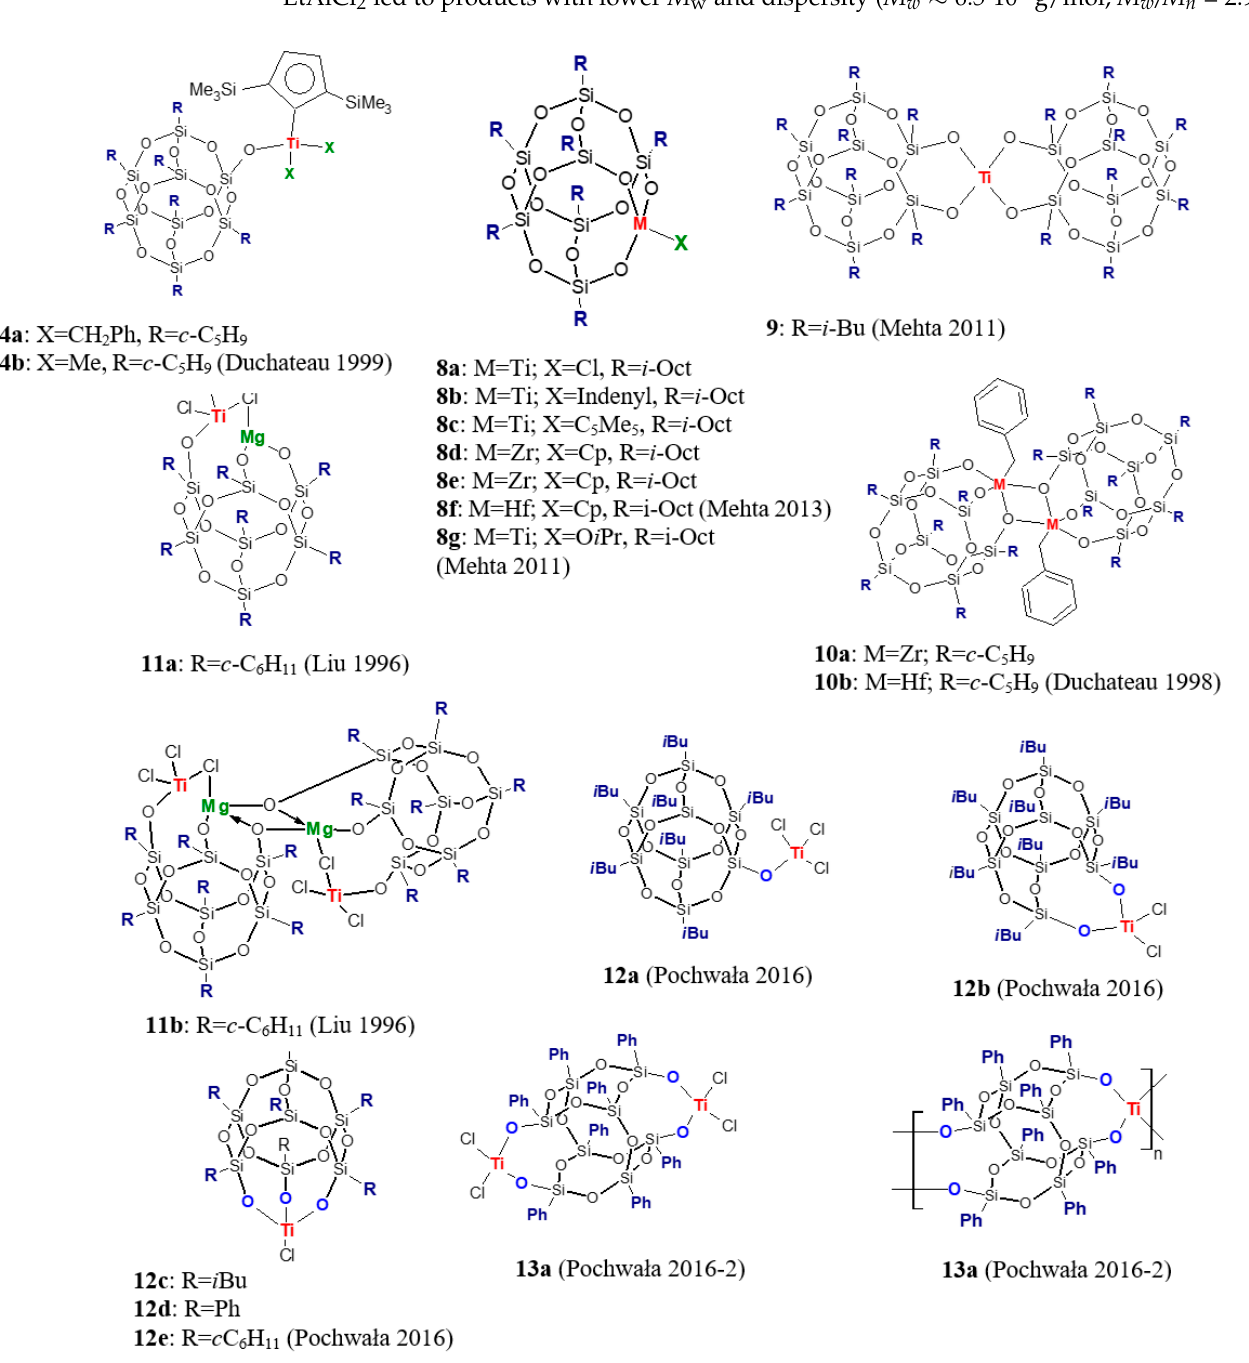
Figure 2. The fourth group transition metals complexes bearing silsesquioxane ligands used in olefin polymerization [39,43–48].